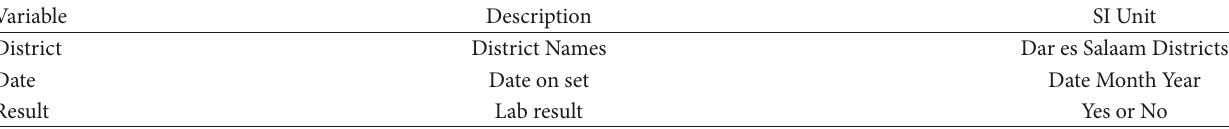
Table 2: Description of cholera cases data with regards to patient details.